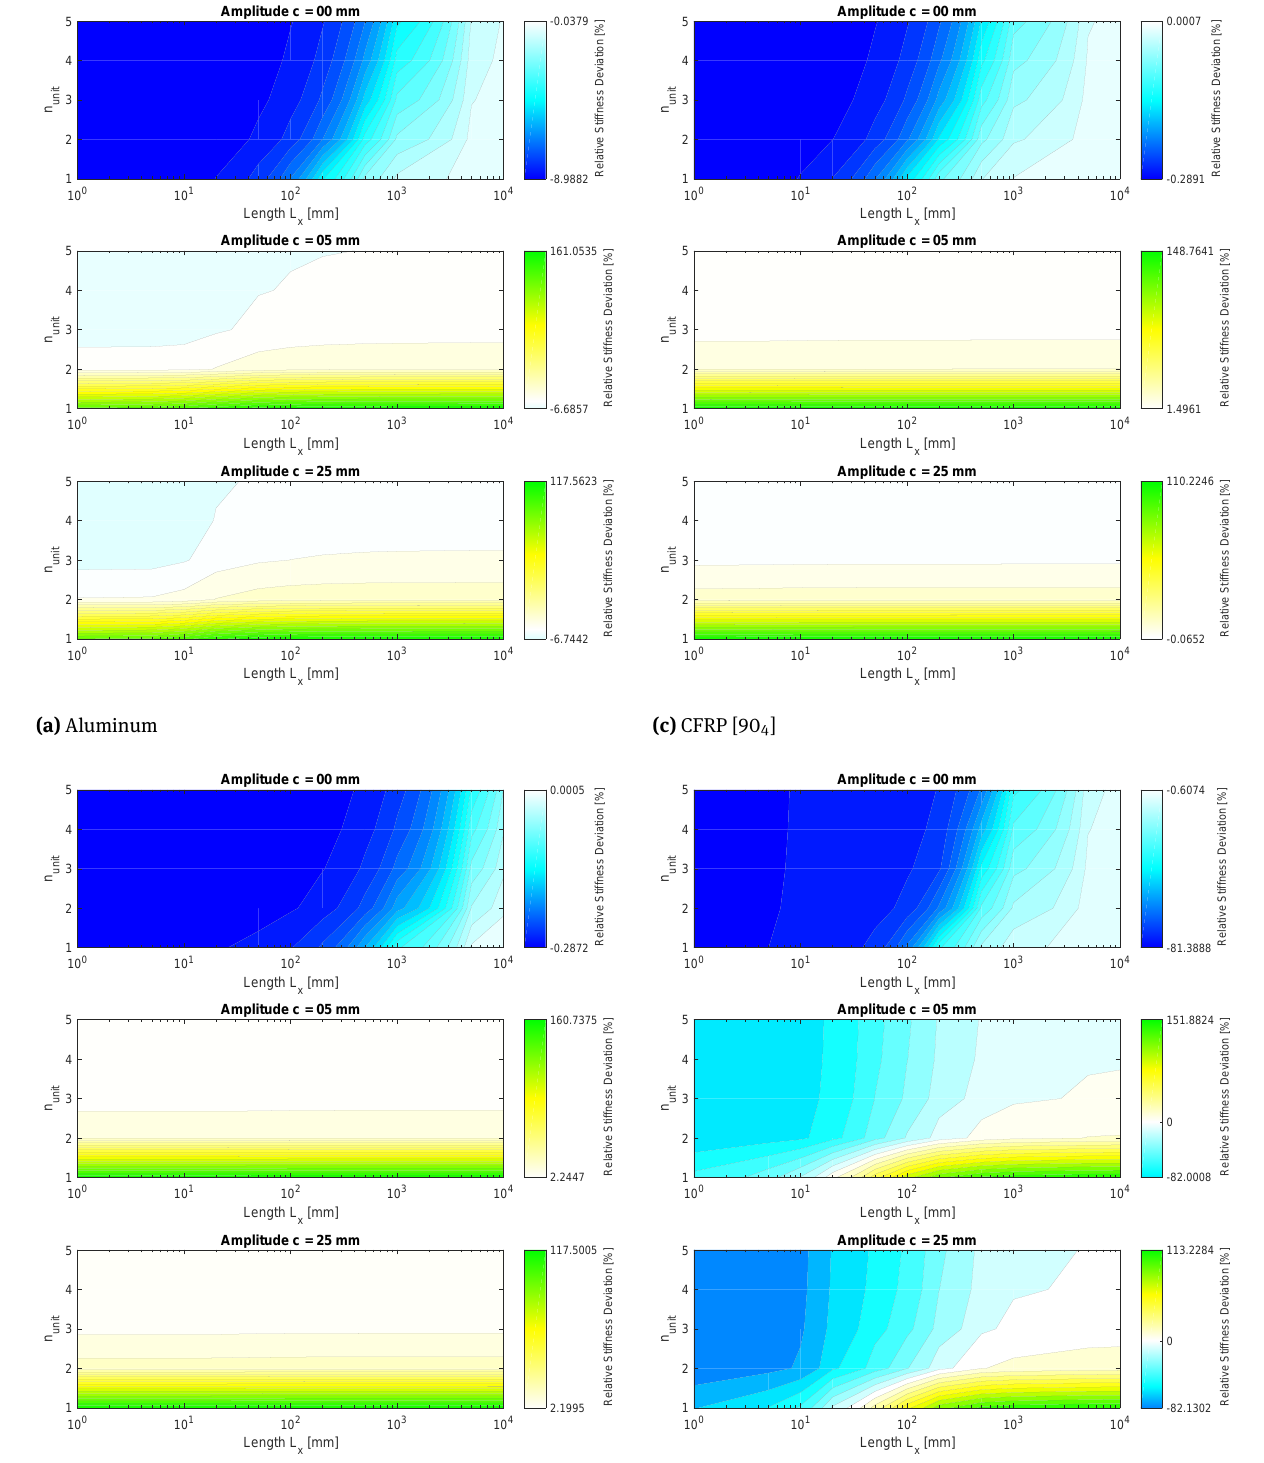
Figure 14: Load case 2 normalized apparent stiffnesses versus L x and n unit - for Aluminum and CFRP [0 4 ]